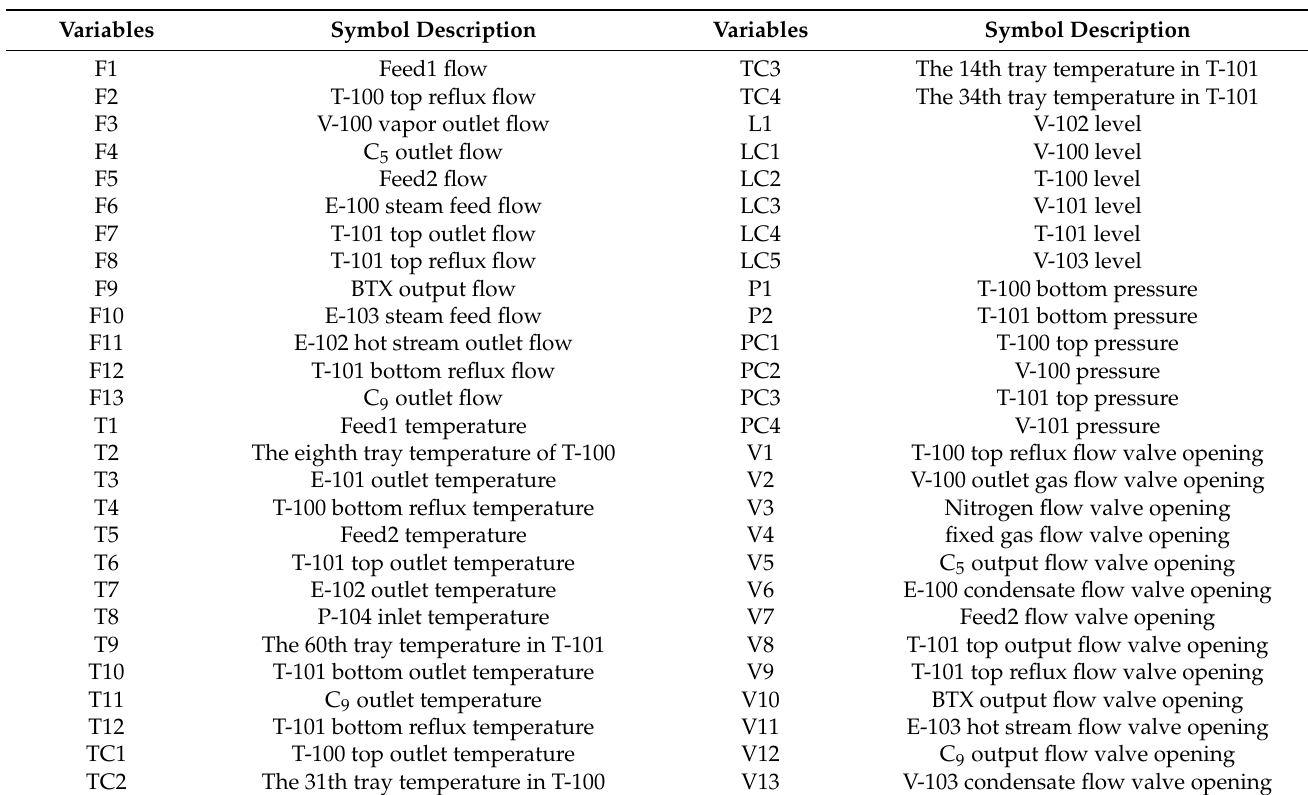
Table 2. The main variables in a hydrogenation prefractionation